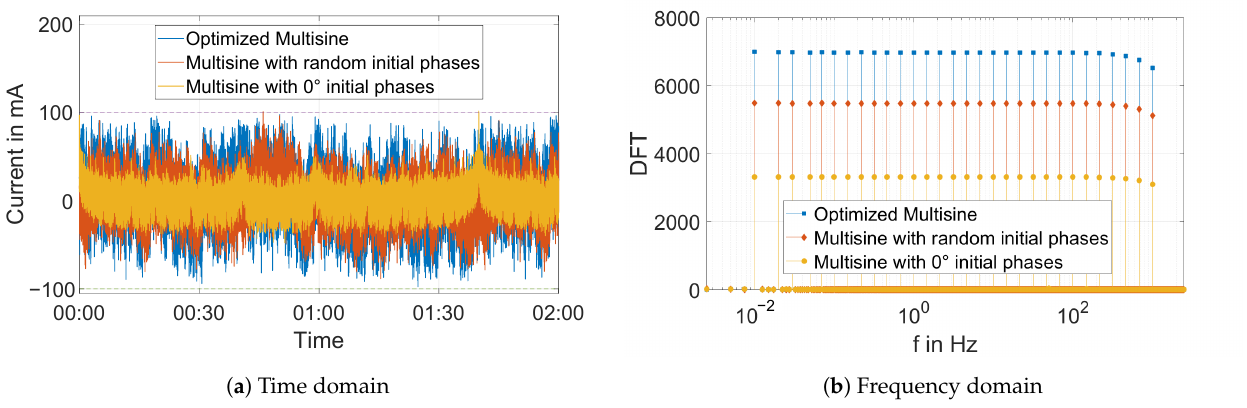
Figure 1. Multisine excitation signals with different initial phases in ( a ) time domain, ( b ) frequency